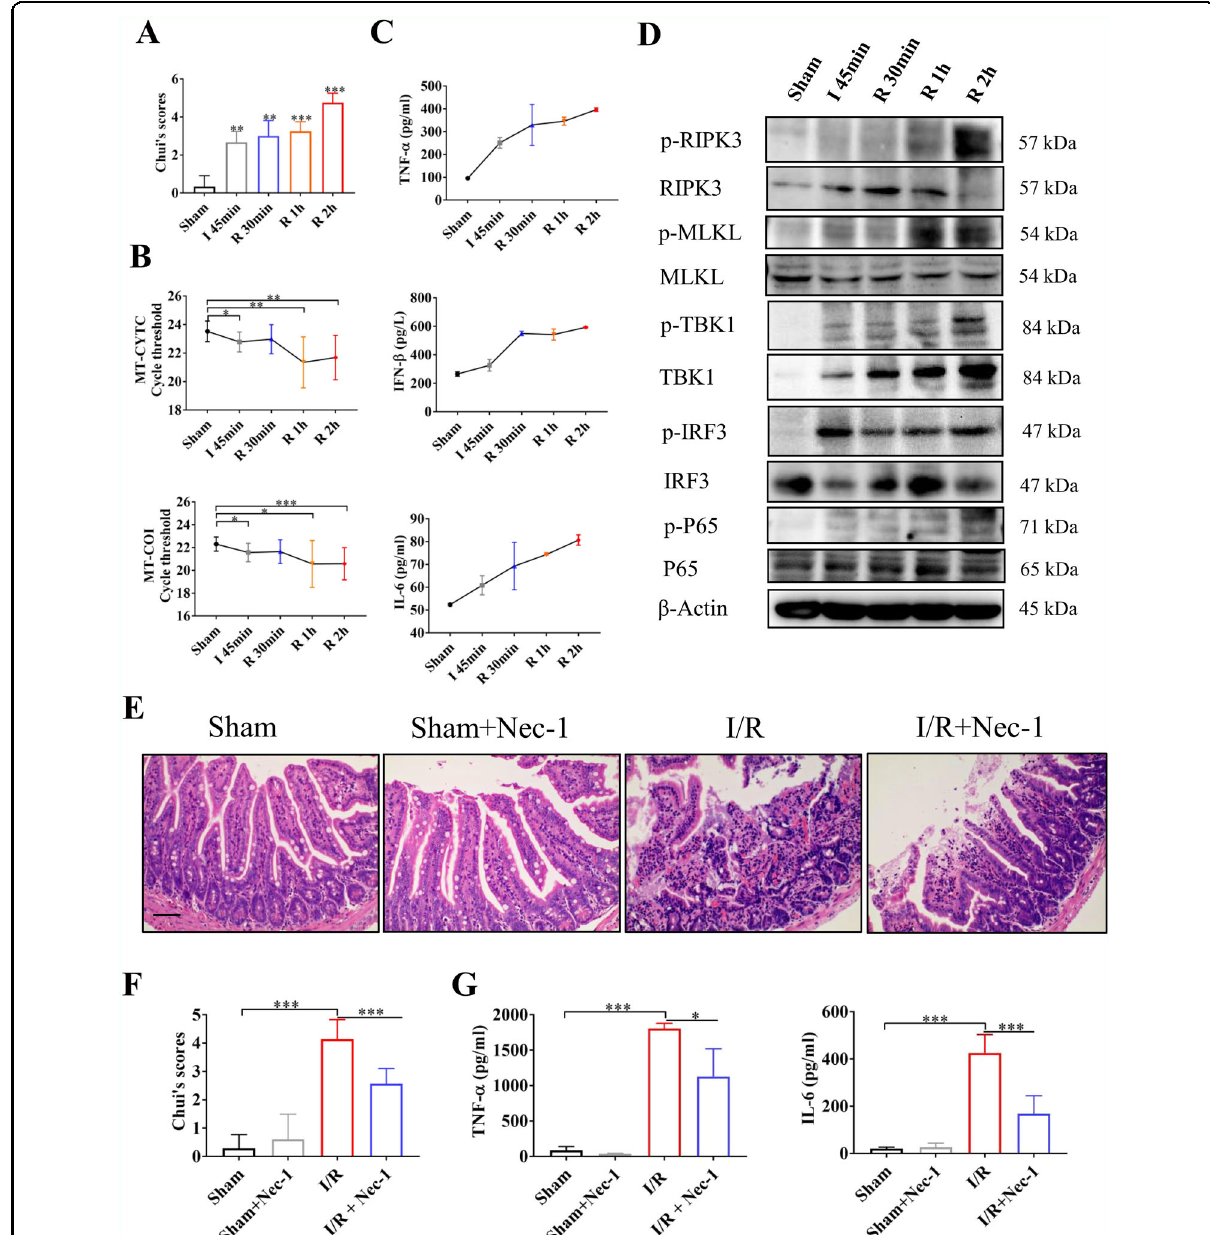
Fig. 4 Necroptosis promotes gut barrier dysfunction following intestinal ischemia reperfusion. ( A ) Chui ’ s score was used to assess intestinal injury for different durations of reperfusion (45 min of ischemia (I 45 min), 30 min of reperfusion (R 30 min), 1 h of reperfusion (R 1 h) and 2 h of reperfusion (R 2 h)). ( B ) mtDNA in the plasma from sham mice and mice with intestinal I/R injury was analyzed via quantitative real-time PCR analysis by amplifying two kinds of mtDNA primers (MT-COI and MT-CYTC). ( C ) Plasma IFN- β , TNF- α , and IL-6 were analyzed by ELISA. ( D ) STING signaling and necroptosis were detected by western blot. ( E ) Representative images of intestinal histology (H&E staining) after intestinal I/R (2 h of reperfusion) or the treatment of necrostatin-1 (nec-1). ( F ) Intestinal injury was assessed by Chui ’ s score. ( G ) Plasma in fl ammatory cytokines (TNF- α and Il-6) were detected by ELISA. Scale bars = 50 μ m. Data were showed as the mean ± SD. * P < 0.05, ** P < 0.01, *** P <